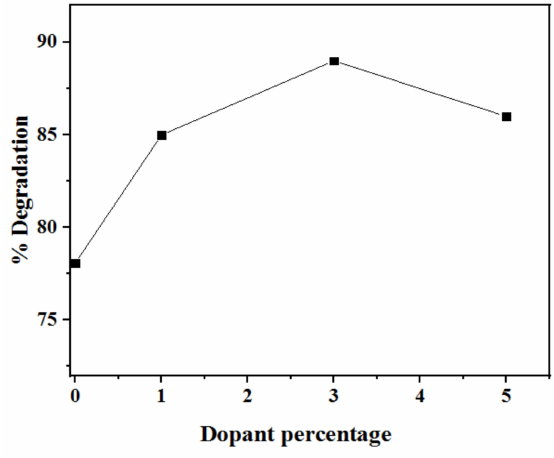
Figure 15. Effect of the variation of amount of Mn 2+ dopant ions on the sonophotocatalytic degrada- tion of SDB at optimum conditions (15 mL of 70 ppm SDB, pH 6, 75 min irradiation, 40 mg Qds).